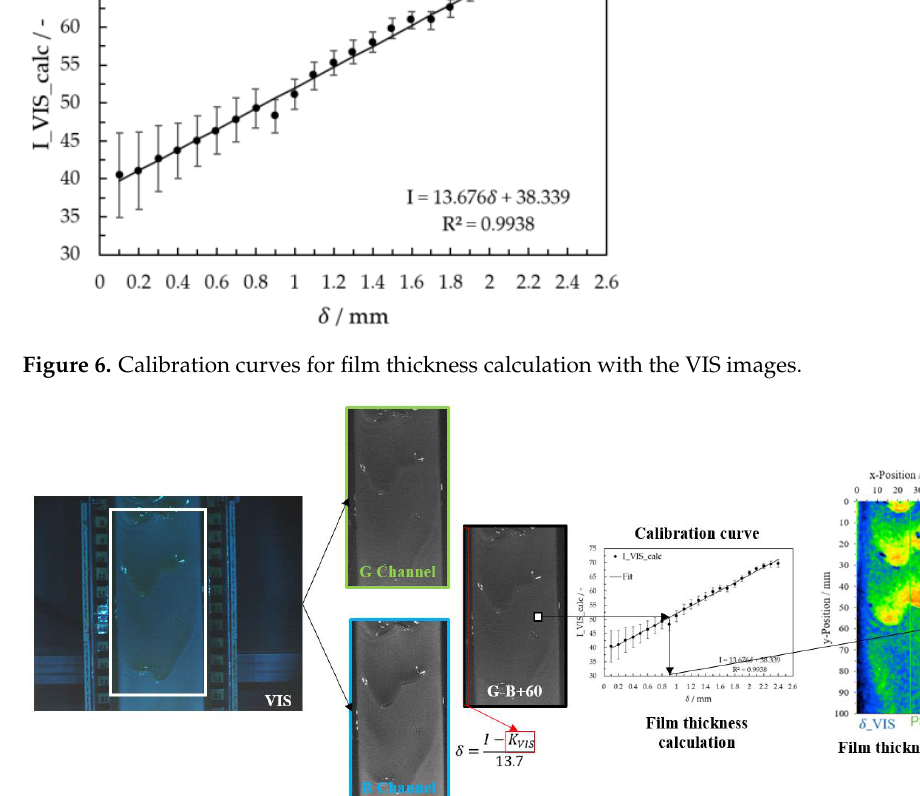
Due to the surface tension, solutions have a higher standard deviation at low film